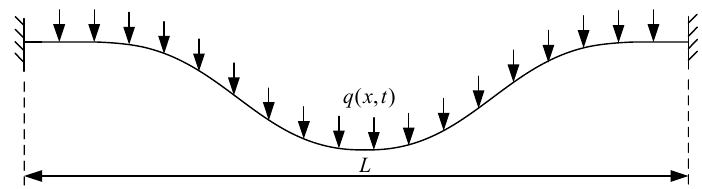
Figure 1. Fixed-fixed beam.